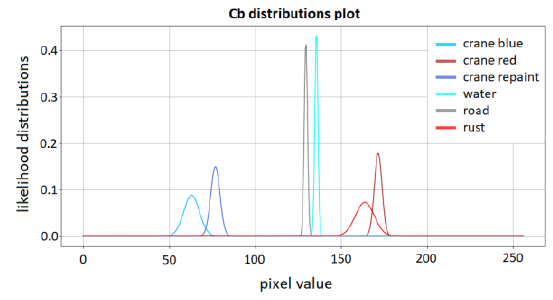
Figure 4. Likelihood representation of some classes